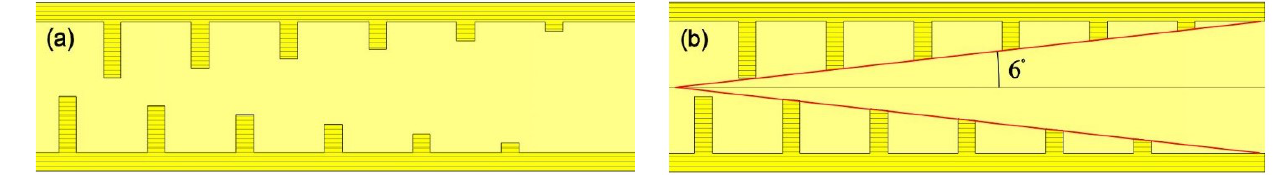
Figure 6. ( a )Transmission loss and ( b ) reflection loss of the complete structure consisting of 50 DSG SWS periods for the initial (red lines) and improved (blue lines) designs of the input/output tapers shown in Figure 4. Figure 5. Schematics of the initial ( a ) and improved ( b ) input/output taper designs.